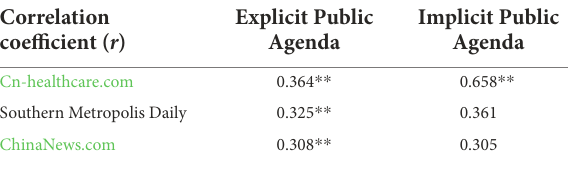
TABLE 4 Effectiveness of agenda-setting in different media networks. Correlation coefficient ( r